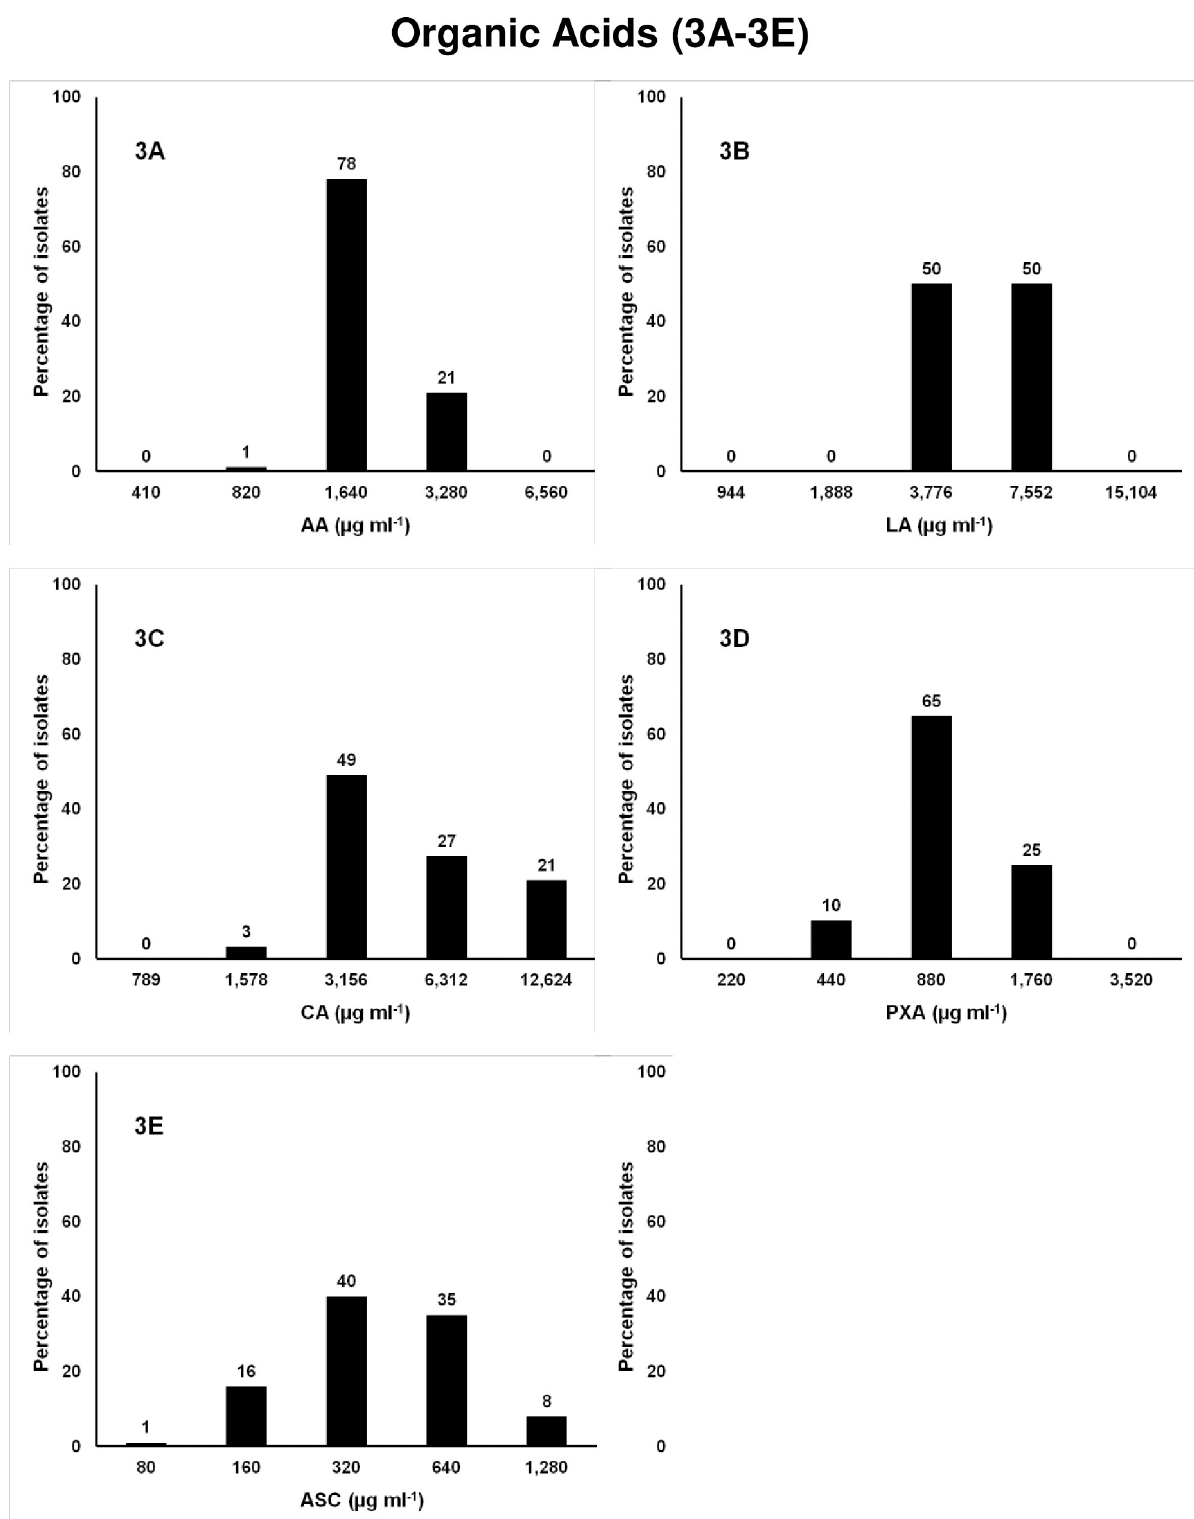
Fig 3. Frequencies of the MICs of 88 MDR Salmonella isolates to organic acids. X-axis is the 2-fold increase of biocide concentration; y-axis is percentage of isolates susceptible at each concentration of organic acids. 3A. Acetic acid, AA; 3B. Lactic acid, LA; 3C. CA, Citric acid; 3D. Peroxyacetic acid, PXA; and 3E. Acidified sodium chlorite, ASC.